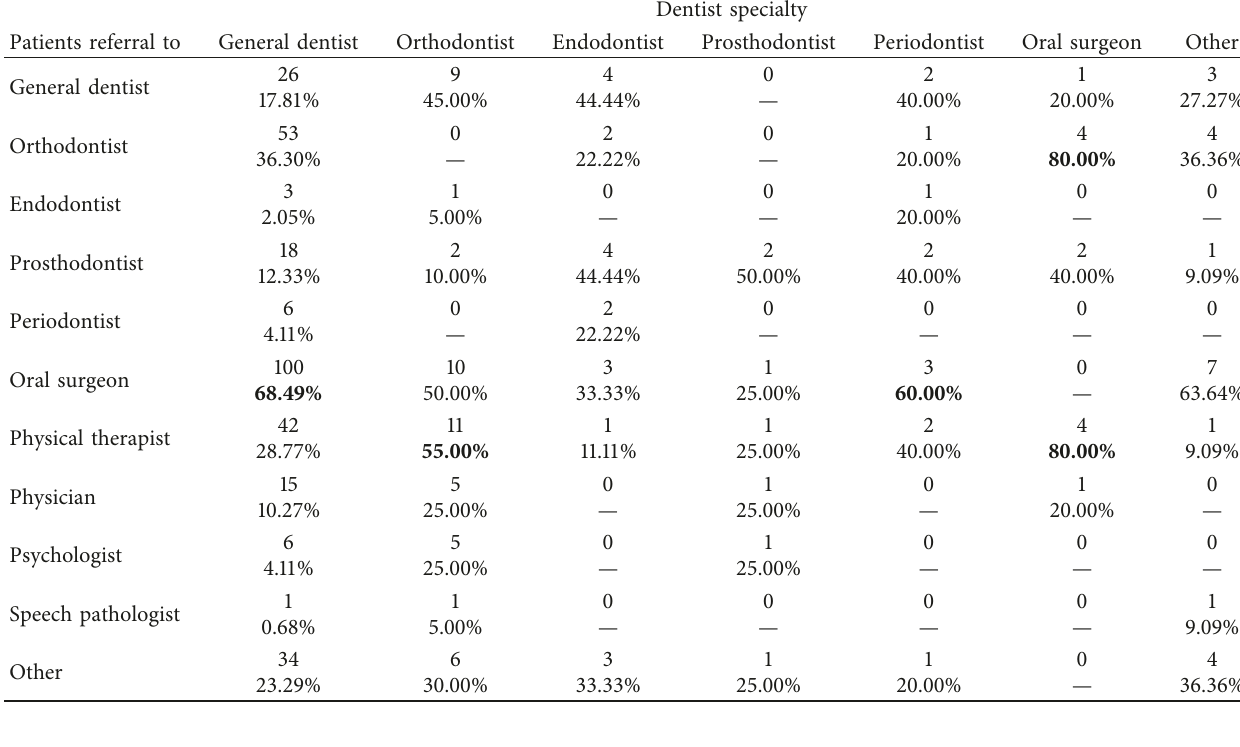
Table 2: Health care providers TMD patients are referred to by dentist specialty (total number and percentage).